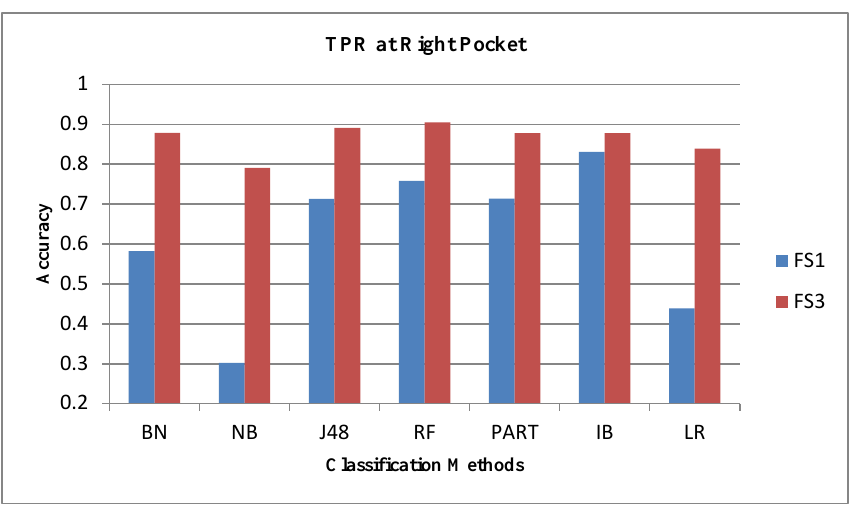
Figure 7. Magnetometer performance for the jogging